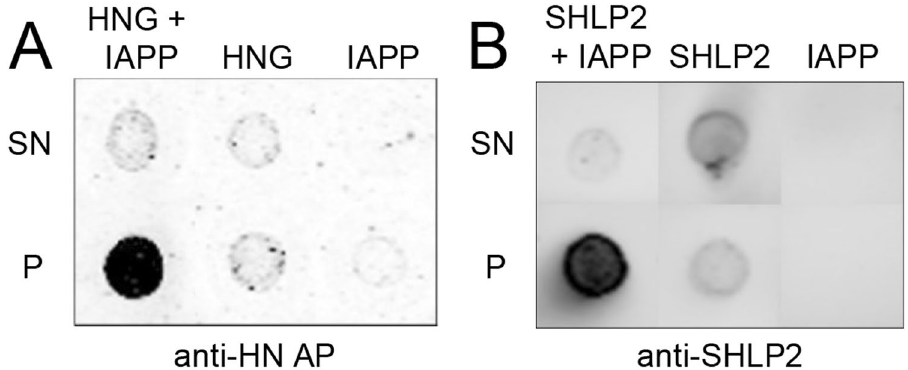
Figure 5. Co-sedimentation assay shows HNG and SHLP2 bind IAPP seeds. ( A ) Representative dot blot from supernatant (top) and pelleted (bottom) fractions of HNG and sonicated pre-formed IAPP fibrils (HNG + IAPP), HNG alone (HNG), or sonicated pre-formed IAPP fibrils alone (IAPP), probed with α -HN AP antibody. ( B ) Representative dot blot from supernatant (top) and pelleted (bottom) fractions of SHLP2 and sonicated pre-formed IAPP fibrils (SHLP2 + IAPP), SHLP2 alone (SHLP2), or sonicated pre-formed IAPP fibrils alone (IAPP), probed with α -SHLP2